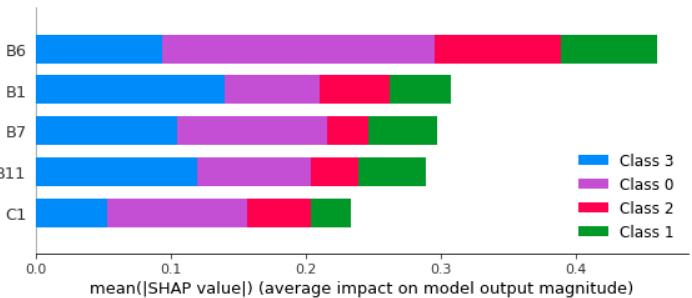
Figure 6. The five most significant features as input in the neural network model for the correct classification of sugarcane varieties. Among the characteristics, the bands B6 (band 6—Vegetation Red Edge), B1 (band 1—Coastal Aerosol), B7 (band 7—Vegetation Red-Edge), B11 (band 11—SWIR), and combination C1 (band 8, band 6, and band 4).